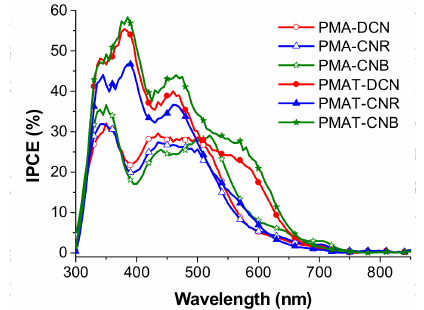
Figure 5. Incident photon-to-electron conversion efficiency (IPCE) spectra of the polymer solar cells (PSCs) with copolymer:PC 71 BM = 1:2 as the active layer.